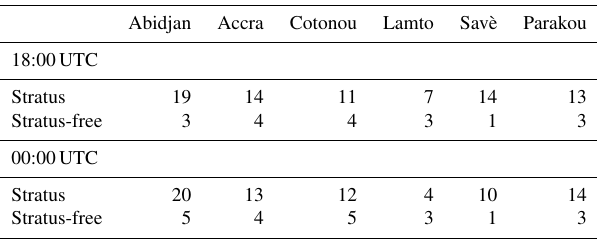
Table 1. The number of radiosonde profiles available at 18:00 and 00:00UTC at coastal stations, Abidjan, Accra and Cotonou, and stations inland of coastal strip, Lamto, Savè and Parakou, during stratus and stratus-free